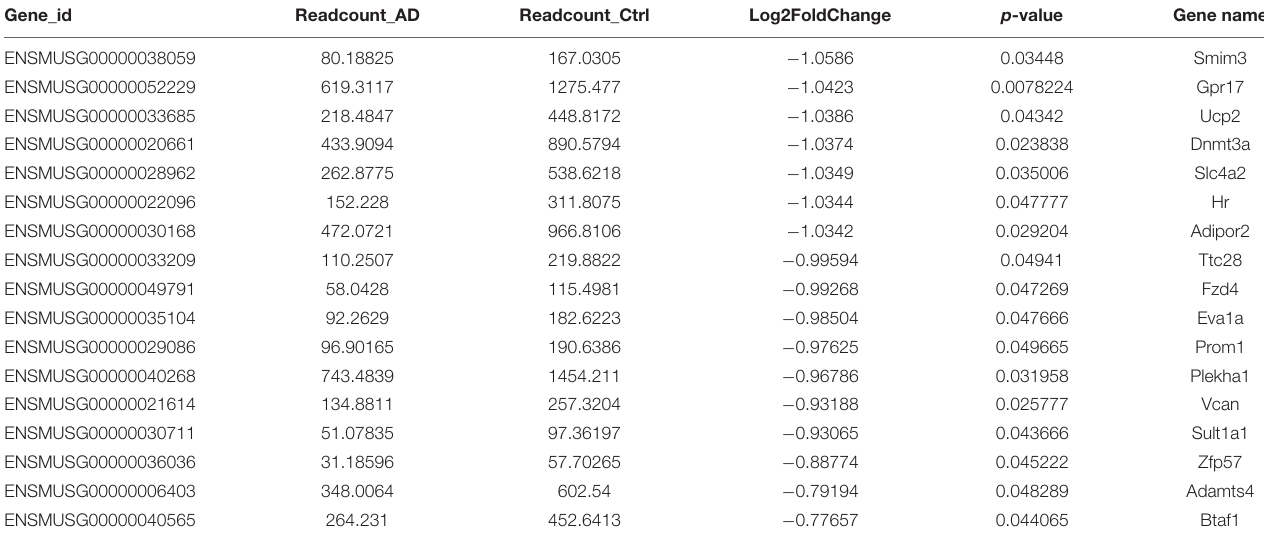
Figure 1B ). KEGG pathway analysis of the